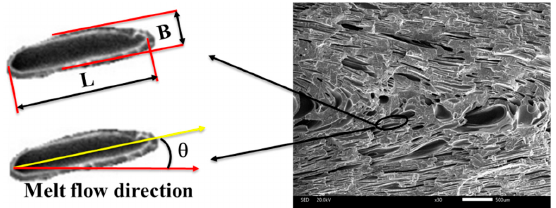
Figure 5. Schematic diagram of ratio of length to diameter ratio and tilt angle.